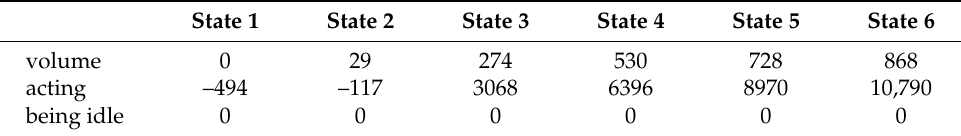
Table 2. Discrete states and their control